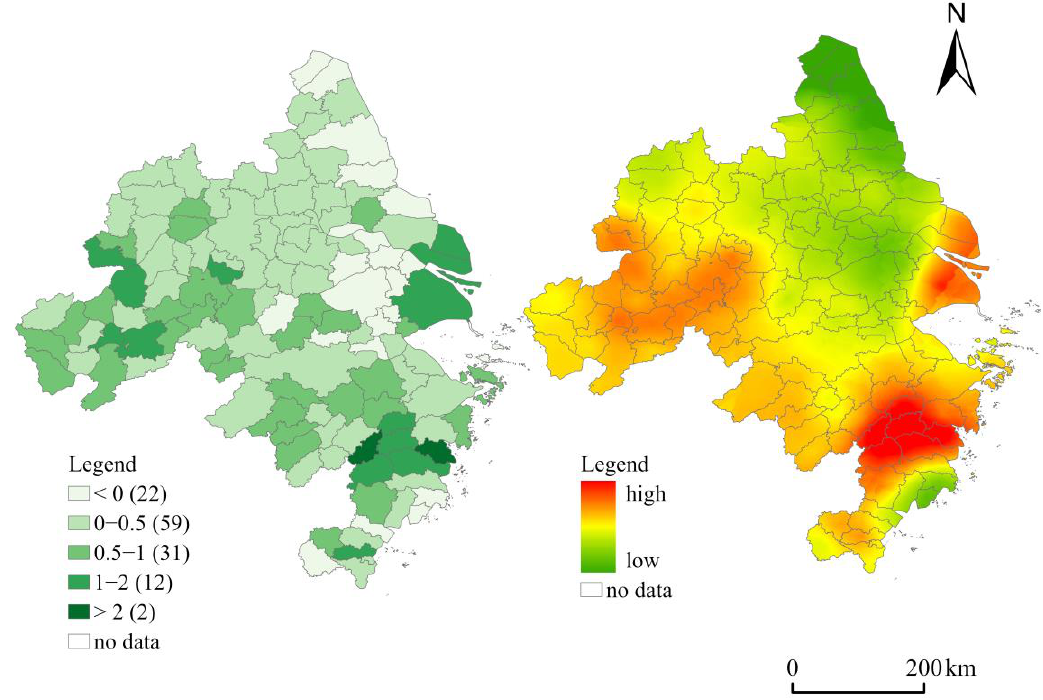
Figure 6. Change in land urbanization growth rate in Yangtze River Delta urban agglomeration from 2010 to 2020.